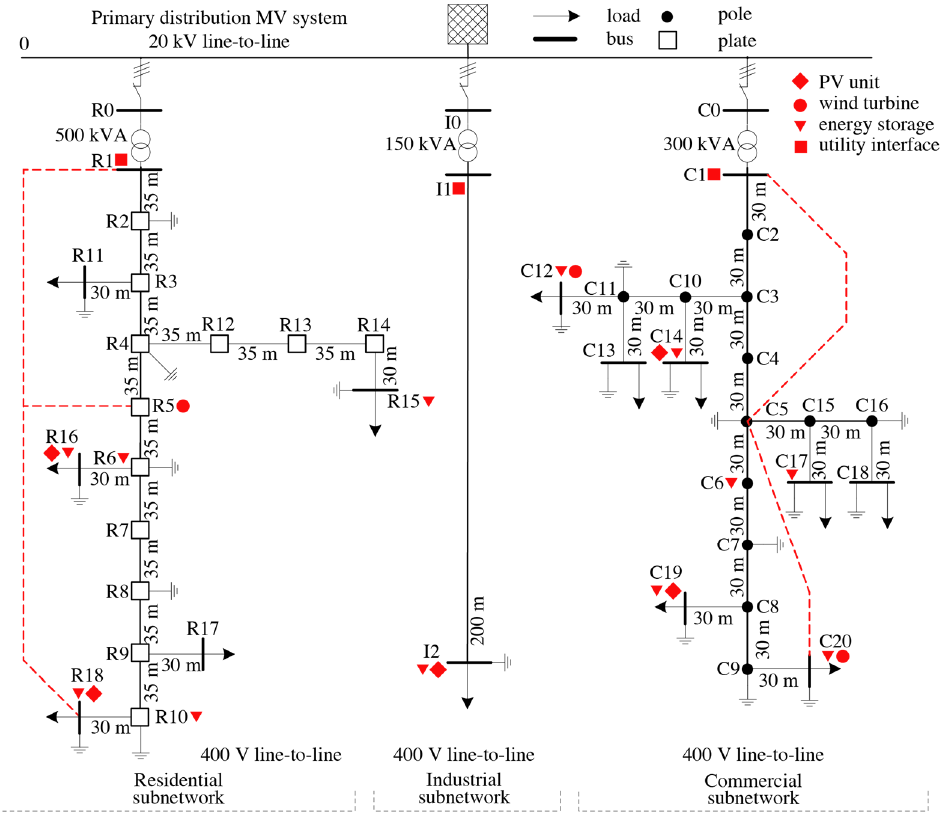
Figure 1. Considered low-voltage European testbench. Details on network parameters are reported in Appendix A [13].